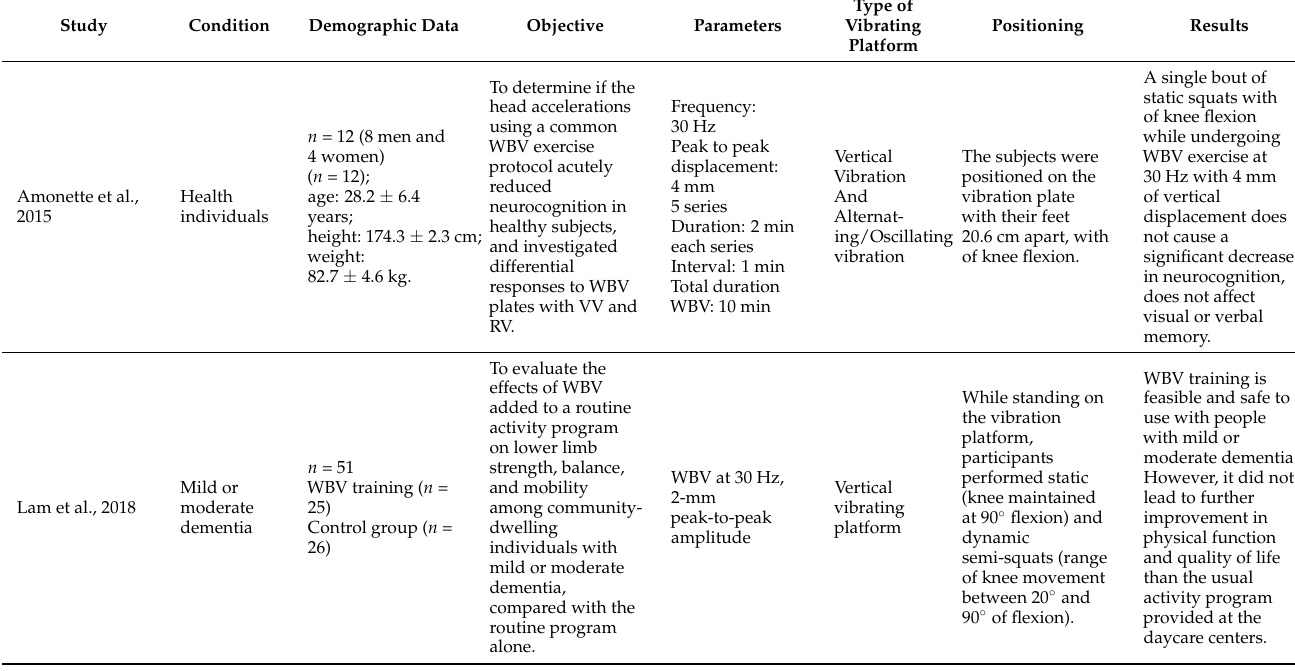
Table 8. Different populations submitted to WBV exercise, with symptoms also observed in the COVID-19 patients: mental